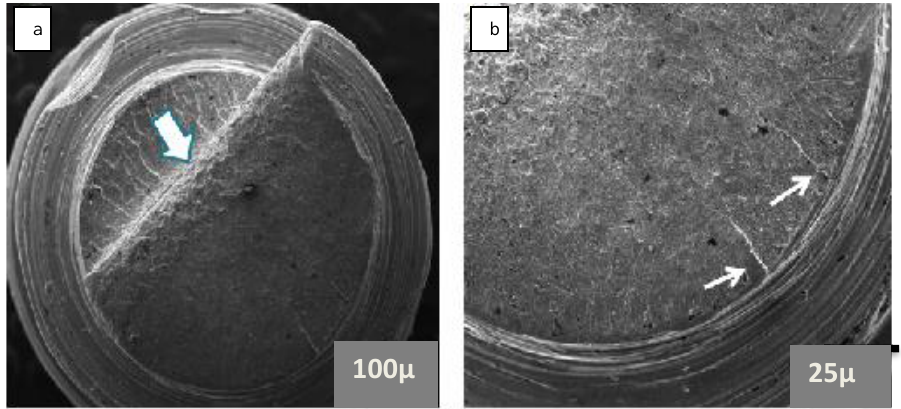
Fig. 5. Scanning electron fractographs of the retrieved implant 2.